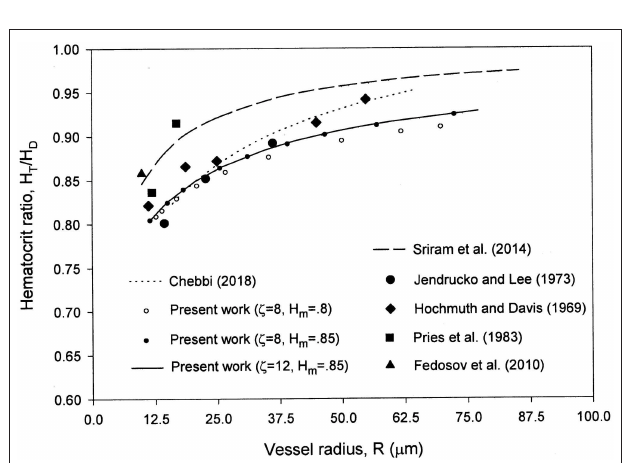
FIGURE 1 | Comparison of the present model with the numerical results in Sriram et al. [ 12] and the cell-free layer thickness experimental data in Long et al. [ 29] reported in Sriram et al. [12] for H D = 0.45.